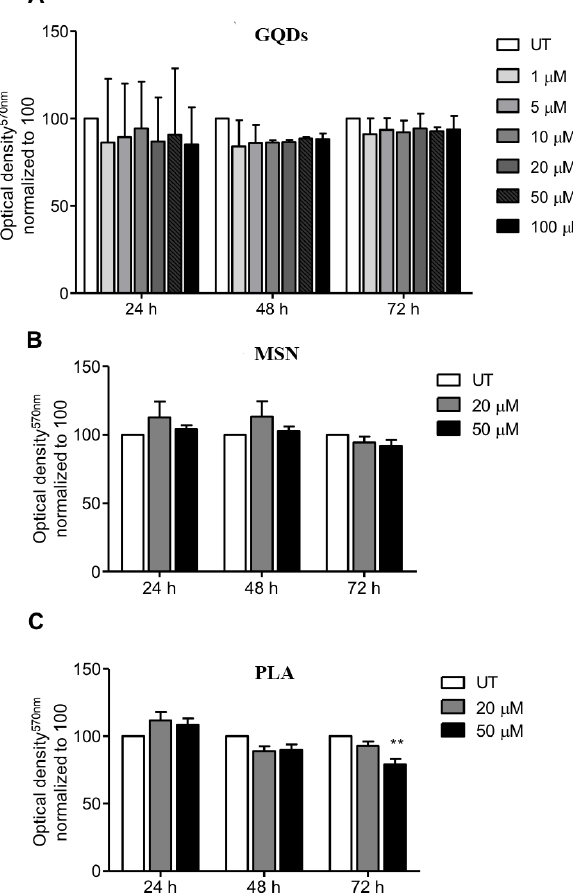
Figure 1. Profile of cell viability of breast cancer cells exposed to a range of nanopolymers concentrations. MDA-MB-231 breast cancer cells were treated with ( A ) graphene quantum dots (GQDs), ( B ) mesoporous silica nanoparticles (MSN) or ( C ) polymeric lactic acid (PLA) for 24, 48 and 72 h. The MTT assay was performed and optical density was obtained at 570 nm. The graphs represent the mean ± standard deviation from three independent experiments. UT: Untreated cells. Statistical significance was analyzed by the one-way ANOVA test (* p < 0.05; ** p <